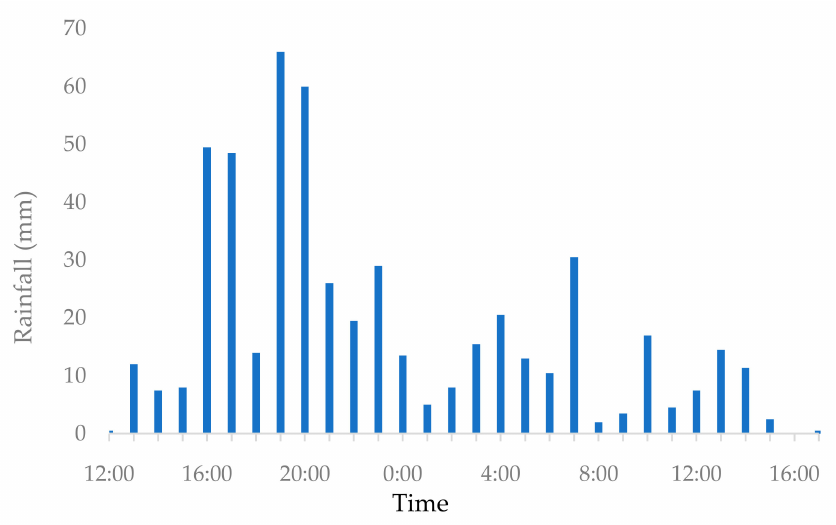
Figure 16. Rainfall distribution in Chiayi County on 23–24 August